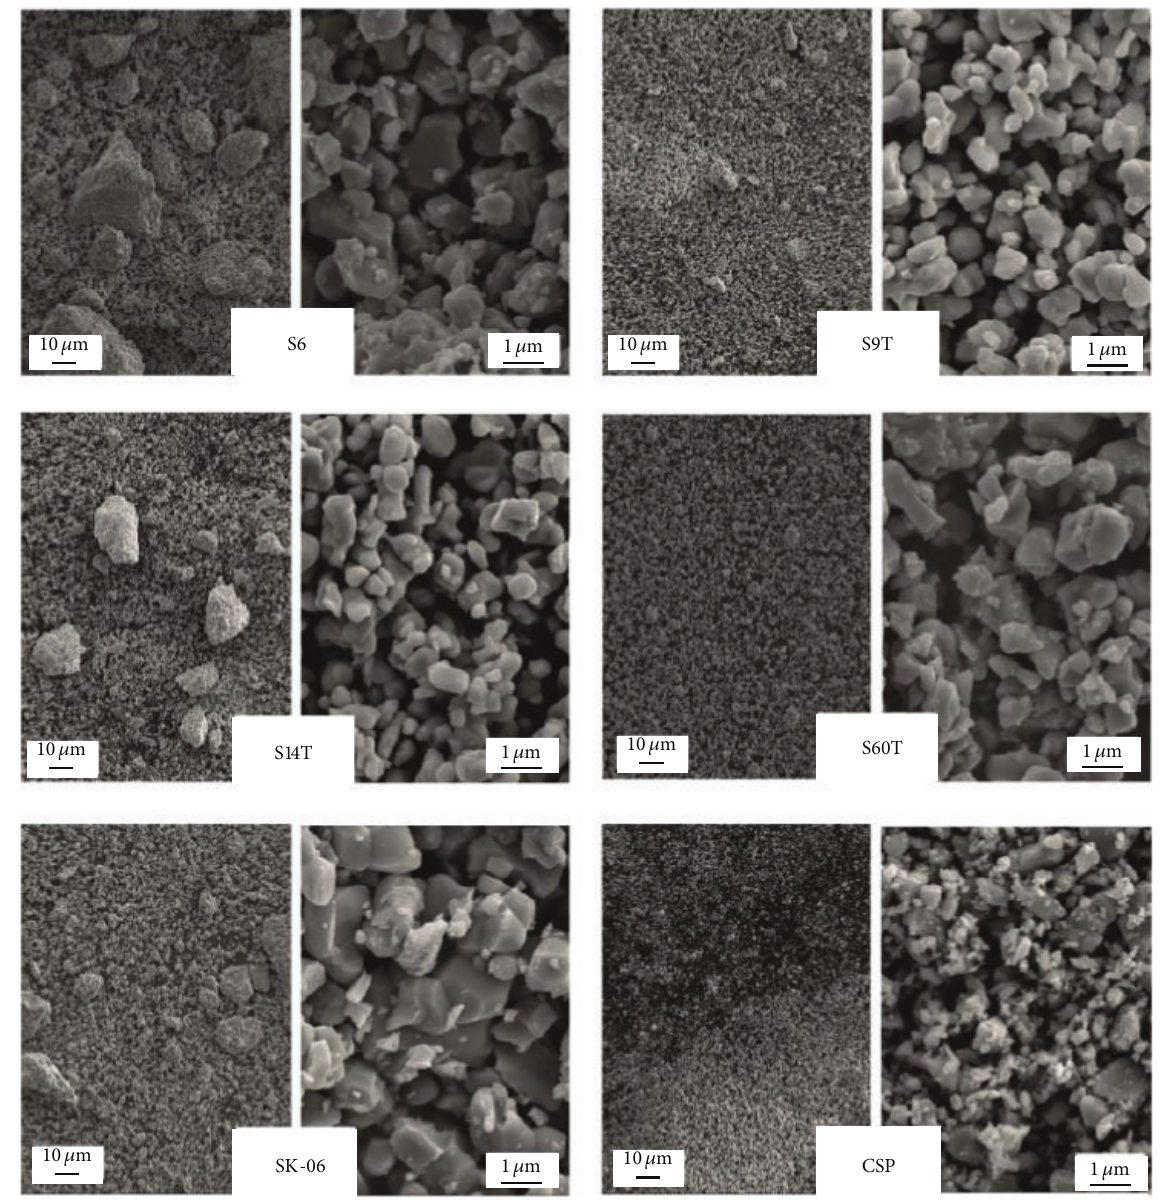
Figure 6: SEM-microscopy images of strontium ferrite powders (different magnifications).